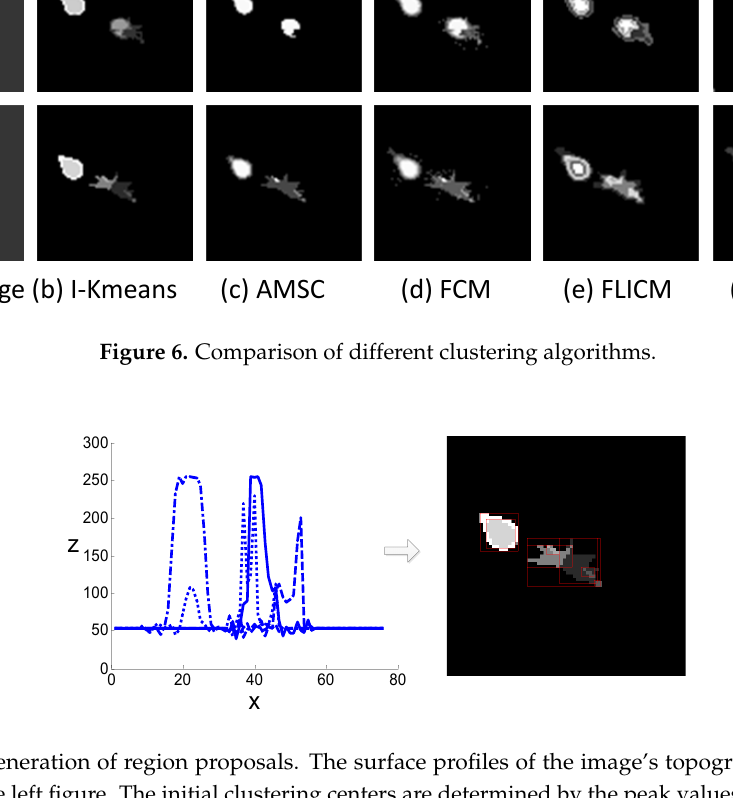
Figure 7. Generation of region proposals. The surface profiles of the image’s topographic map are shown in the left figure. The initial clustering centers are determined by the peak values of the surface profiles. The final cluster result and corresponding region proposals are shown in the right